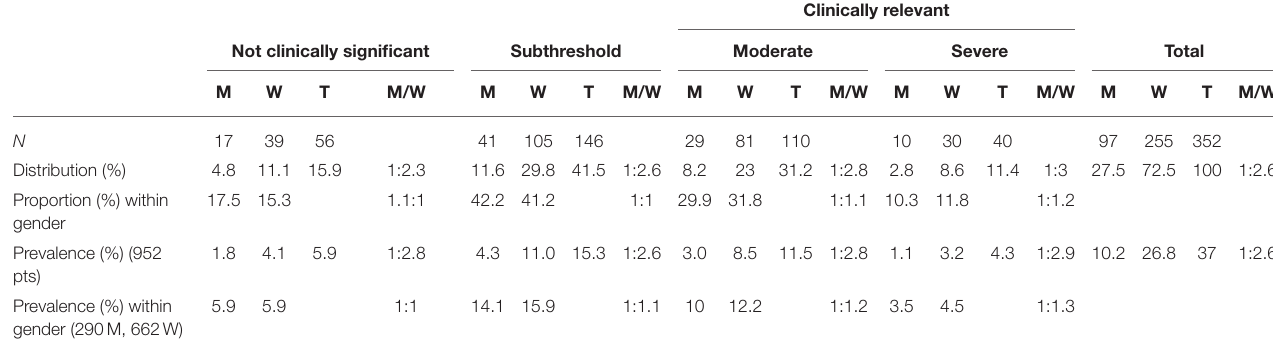
M/W, ratio men to women; pts, patients.